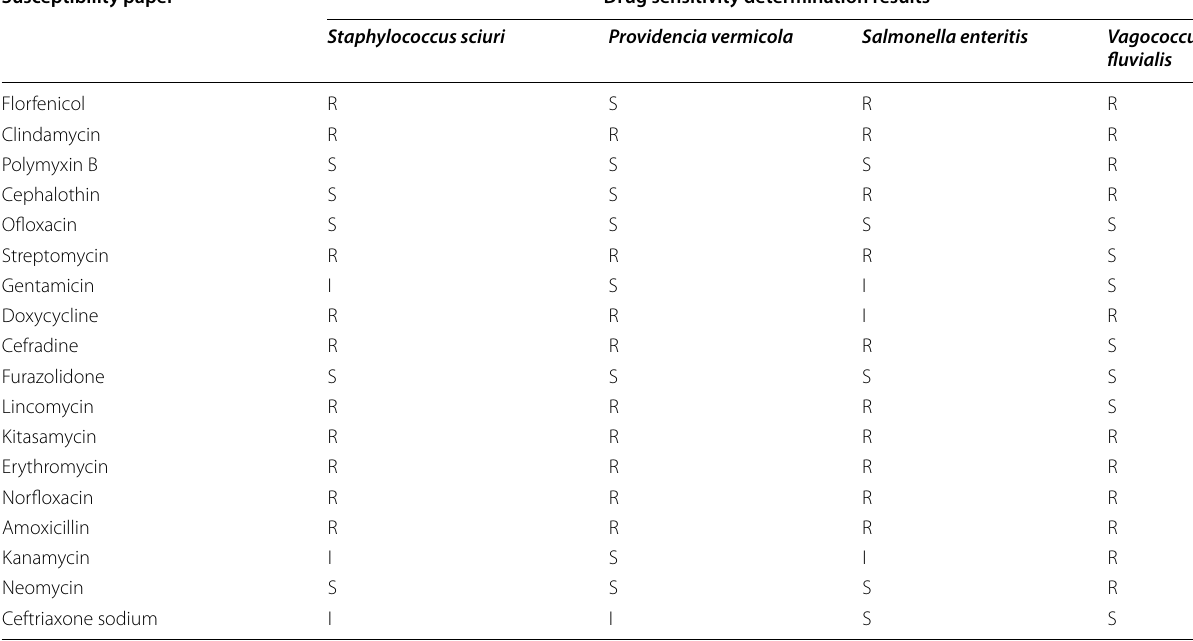
Table 1 Drug sensitivity determination